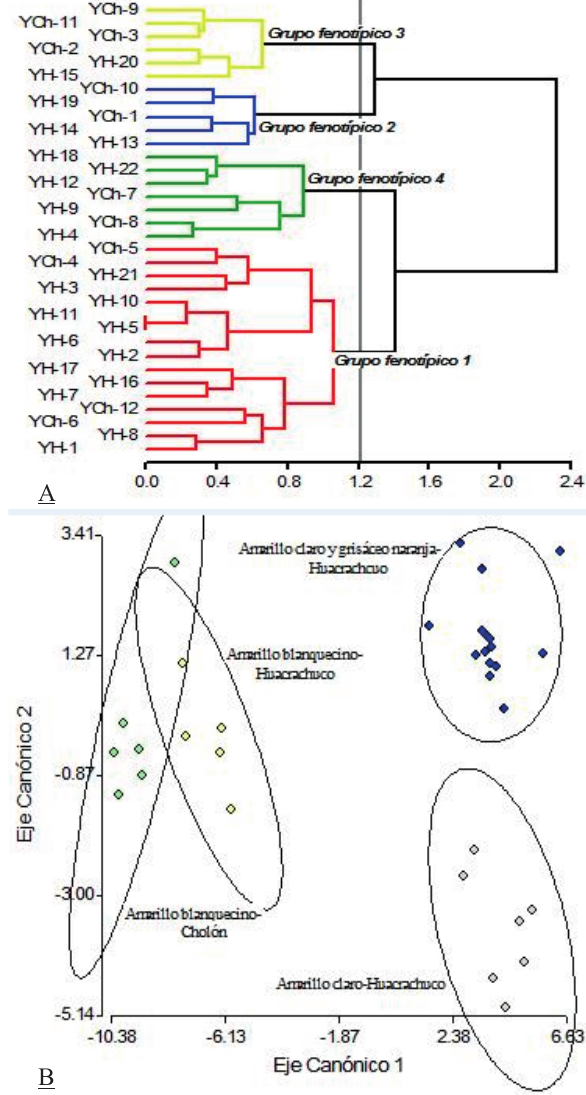
Figure 4. Dendogram (Ward method, Gower distance) and prediction ellipses for the phenotypic classification of 34 yacon samples ( S. sonchifolius ) grown in the province of